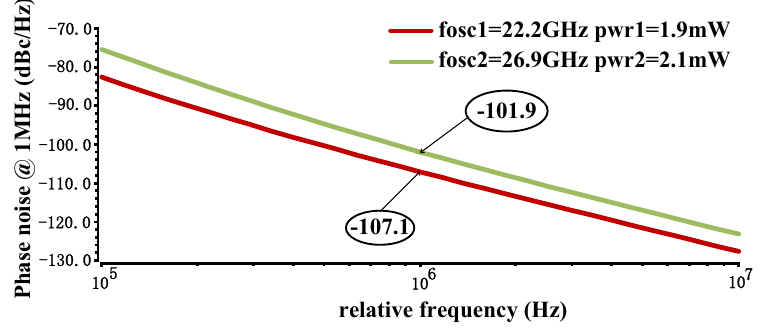
Figure 8. Phase noise of VCO at 22.2 GHz and 26.9 GHz. When the VCO operates at the lowest operating frequency of 22.2 GHz, it has the minimum phase noise of − 107.1 dBc/Hz and the lowest power consumption of 1.9 mW. The transient simulation is depicted in Figure 9. The proposed structure has an asymmetry differential output with an output swing of around 300 mV. The imbalance of outputs will affect the phase noise performance, so a more effective way to improve the symmetry of current-reused topology is needed. From the spectrum of output waveform, the total harmonic distortion (THD) can be calculated. Since the fundamental wave is much larger than the third harmonic, higher harmonic components are ignored and the THD can be regarded as the difference between the fundamental wave and the second harmonic component. When VCO operates in the lowest frequency. The approximate value of THD is − 40.6